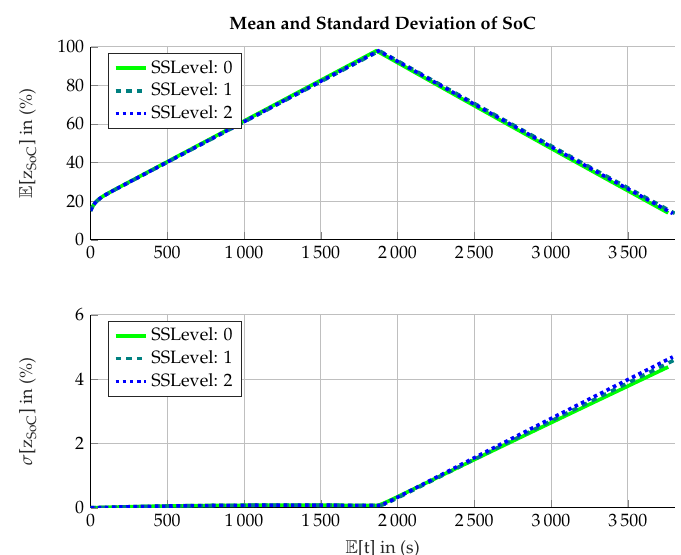
Figure 10. Mean and standard deviation value for state-of-charge over time for charge–discharge cycle.